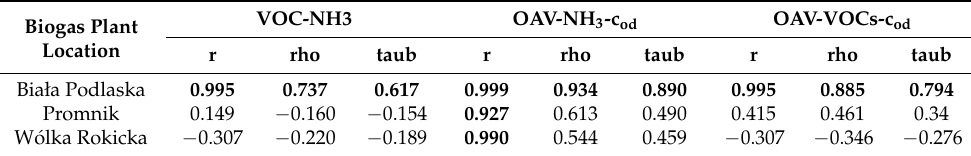
Table 4. Correlation coefficients between VOC and ammonia concentrations, OAV-NH 3 and c od , and OAV-VOCs-c od at individual